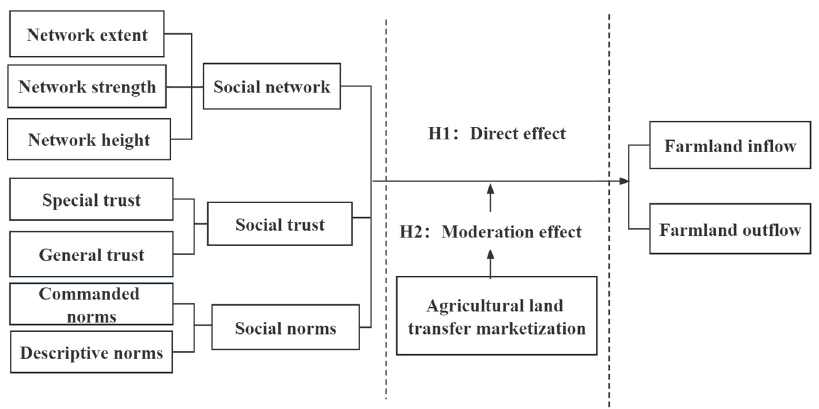
Figure 1. Theoretical analysis framework.